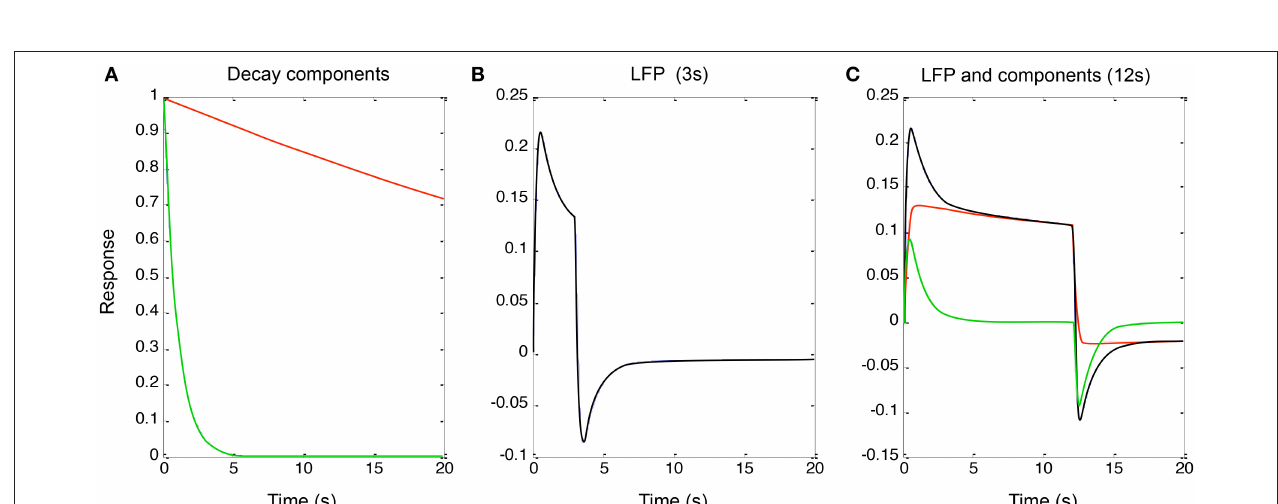
FIGURE 4 | (A) Two exponential decay processes (red and green curves) used to account for the adaptation effects in Figure 2 . (B) The properties of Equation (4) for a stimulus of 3s duration. (C) The same for 12s duration (black curve), together with the components making it up (red and green curves). (See text for details).